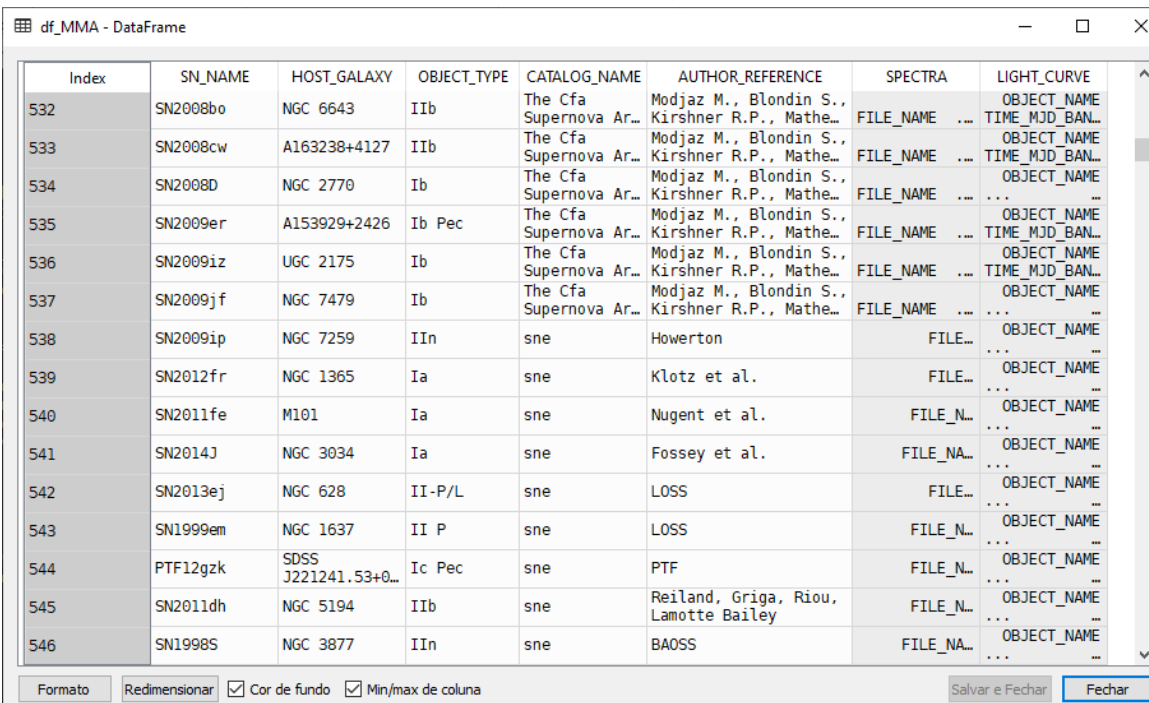
Figure 9. MMA-Supernova Protocol first